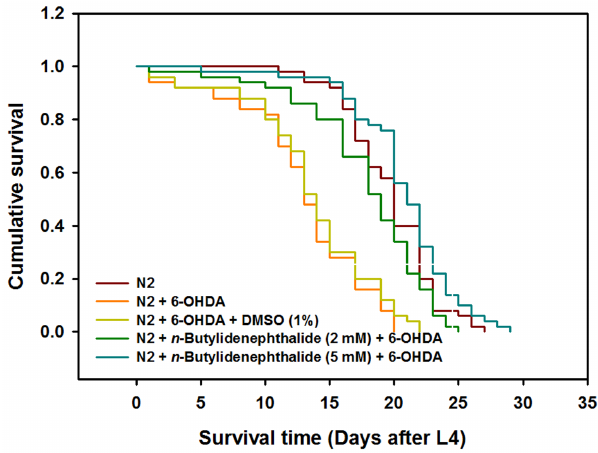
Figure 8. n -Butylidenephthalide prolongs longevity in 6- OHDA-treated N2 C.elegans . Cumulative survival curves of wild- type N2 animals grown on OP50, 6-OHDA-treated animals grown on OP50, and n -butylidenephthalide/6-OHDA-treated animals fed on n - butylidenephthalide/OP50.